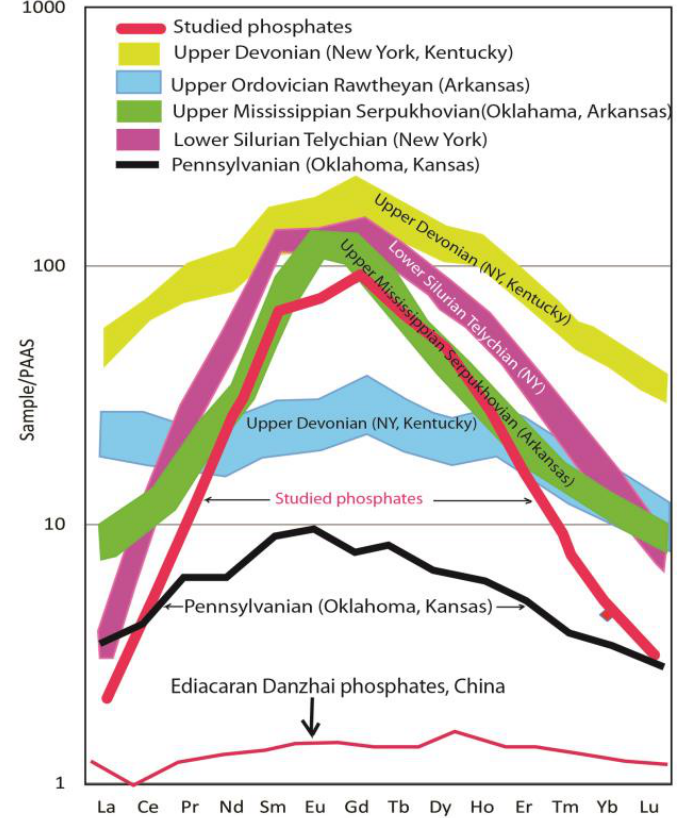
Figure 7. Comparison of PAAS-normalized REE patterns in different sedimentary phosphates. Data from [74,75].